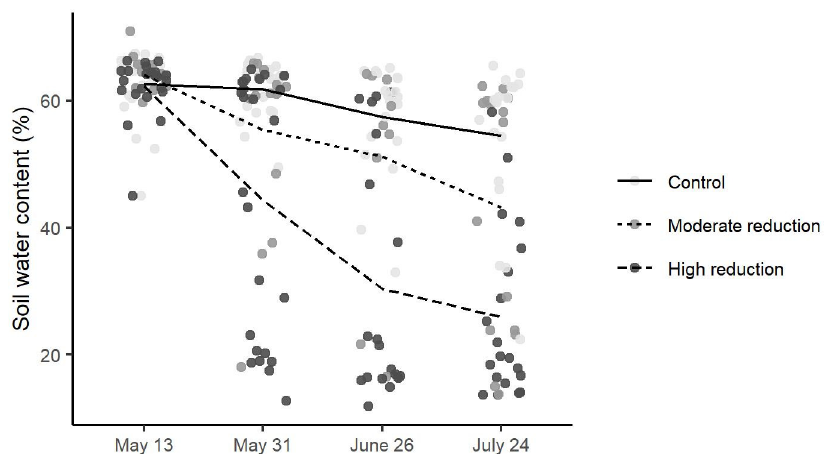
Figure A1. Soil water content during ten weeks of growth under three levels of water availability from a greenhouse experiment. Soil water content was measured for every water availability treatment (control: 80% of pot capacity; moderate reduction: 50%; high reduction: 25%) by sampling soil from random seedling pots and calculating percentage ((wet mass − dry mass)/wet mass × 100) ( n = 25/water availability treatment). Water availability treatments began on May 10. Watering frequency was reduced from once every three days to once every four days after three weeks of the experiment (6 June 2019) due to high water content in the high reduction treatment.